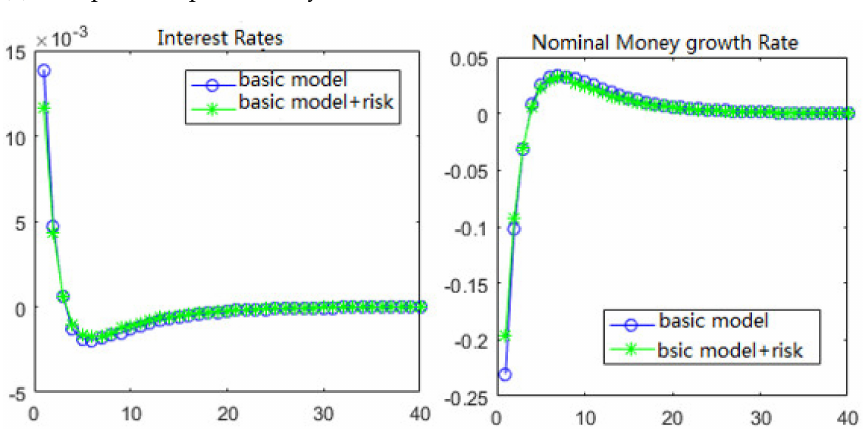
Figure 7. Comparison of impulse response results between price and quantitative monetary policy (basic model; extended